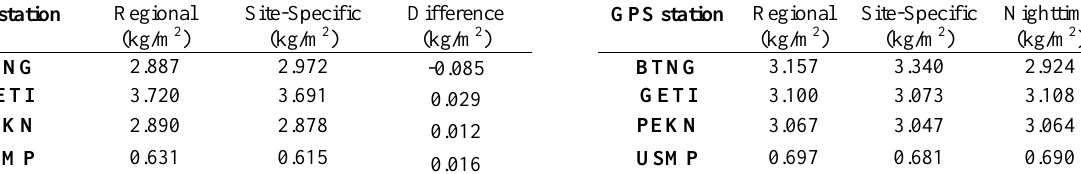
Table 10: Comparison between regional, site-specific and nighttime T M models during nighttime observation. The RMSE is slightly reduced by using nighttime T M